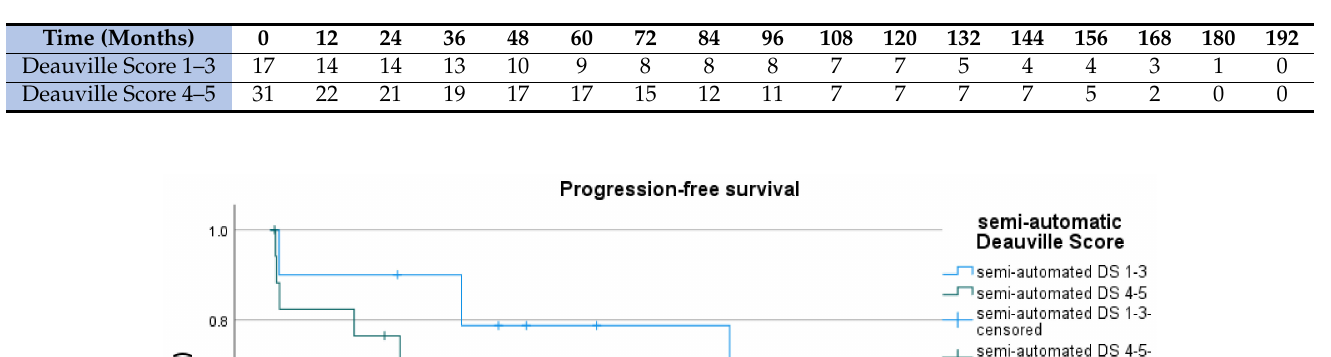
Figure 5. PFS for visual/manual DS. Table 7. Number at risk.